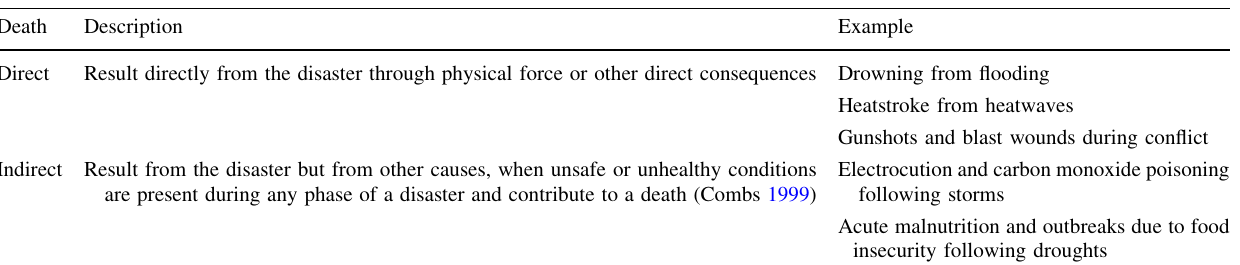
Table 1 Examples of direct and indirect disaster death definitions. Source Adapted from IRDR